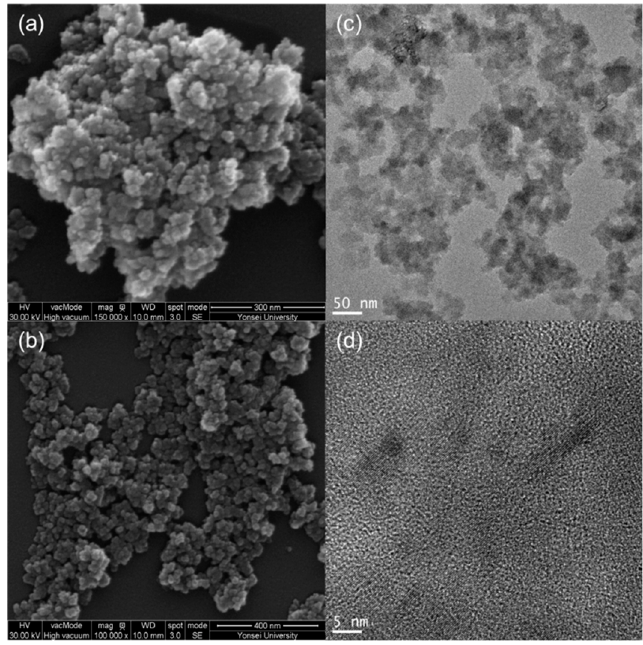
Figure 4. Morphology and pore texture of CPSOH. SEM images ( a , b ) and TEM images ( c , d ).